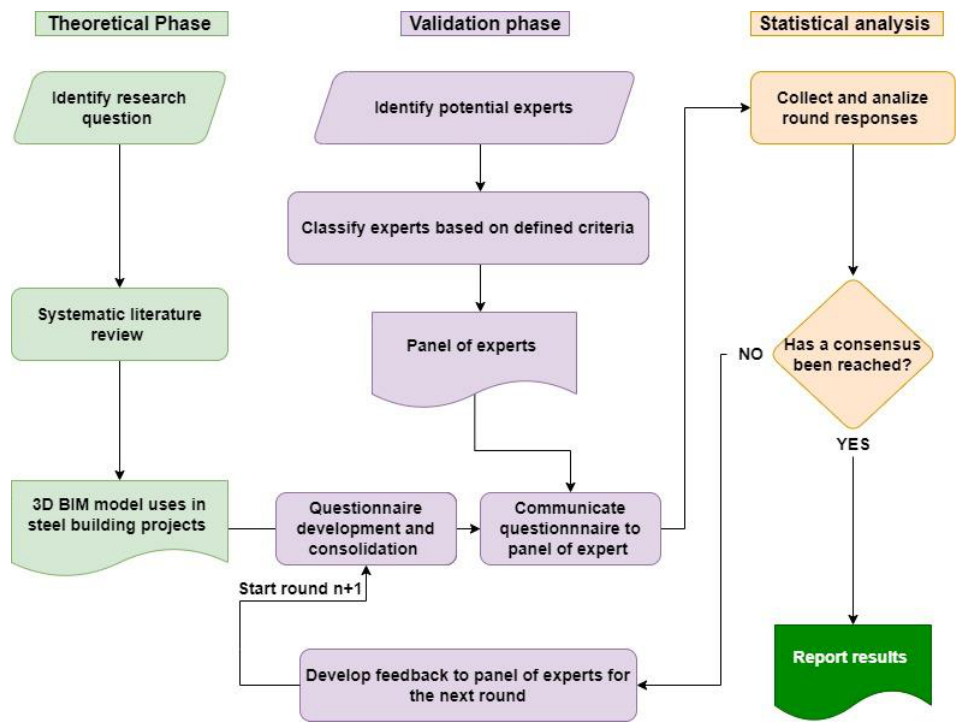
Figure 2. Flow chart of the methodology employed in this study [62].